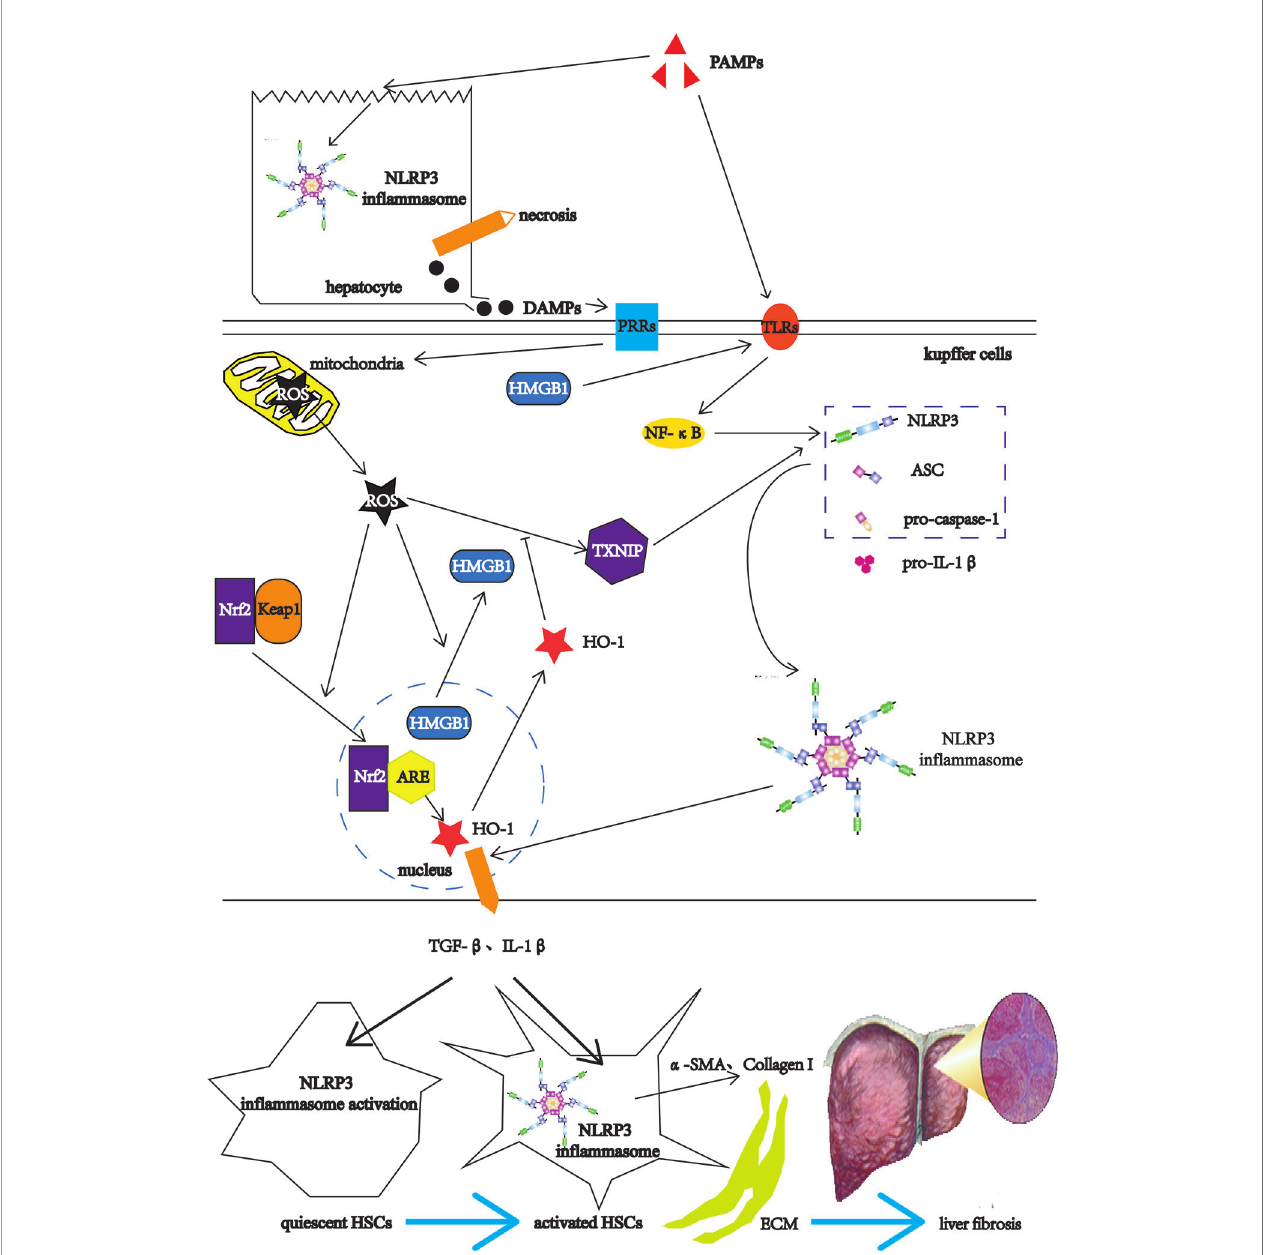
FIGURE 3 | The NLRP3 in fl ammasome in the liver fi brosis. After the PAMPs act on the livers, they destroy the hepatocytes, and activate the NLRP3 in fl ammasomes in hepatocytes, leading to hepatocyte necrosis. The necrotic liver cells release DAMPs, which can activate Kupffer cells (KCs). The KCs recognize PAMPs through TLRs on the one hand, and induce the expressions of NLRP3 in fl ammasome-related pathway components such as NLRP3, pro-caspase-1, and pro-IL-1 b through TLRs-NF- k B pathways. On the other hand, the KCs recognize DAMPs, which can directly damage mitochondria and cause them to release ROS. As the upstream signal of NLRP3, ROS activates NLRP3 through the ROS-TXNIP pathway. ROS also promotes the transfer of high mobility group box 1 (HMGB1) from the nucleus to the cytoplasm. The HMGB1 can also activate NLRP3 through the TLR4-NF- k B pathways. After NLRP3 is activated, NLRP3 forms NLRP3 in fl ammasome together with ASC and pro-caspase-1. Nuclear factor erythroid 2-related factor 2 (Nrf2) is an important transcription factor that regulates cellular anti-oxidative stress. Under physiological conditions, the cytoplasmic protein chaperone molecule Kelch-like ECH-associated protein 1 (Keap1) in KCs binds to Nrf2 and makes it appear to be inhibited. When mitochondria release ROS, Nrf2 dissociates from Keap1 and moves into the nucleus, and combines with the antioxidant response element (ARE) to activate the antioxidant enzyme heme oxygenase-1 (HO-1) expression to inhibit the activation of ROS/NLRP3 in fl ammasome pathways. The antioxidant response cannot resist the oxidation response, which leads to the KCs activation. Activated KCs activate HSCs by releasing TGF- b and IL-1 b , which activate the NLRP3 in fl ammasome in HSCs. The activated HSCs express a -smooth muscle actin ( a -SMA) and Collagen I, leading to ECM deposition and eventually progressing into liver fi